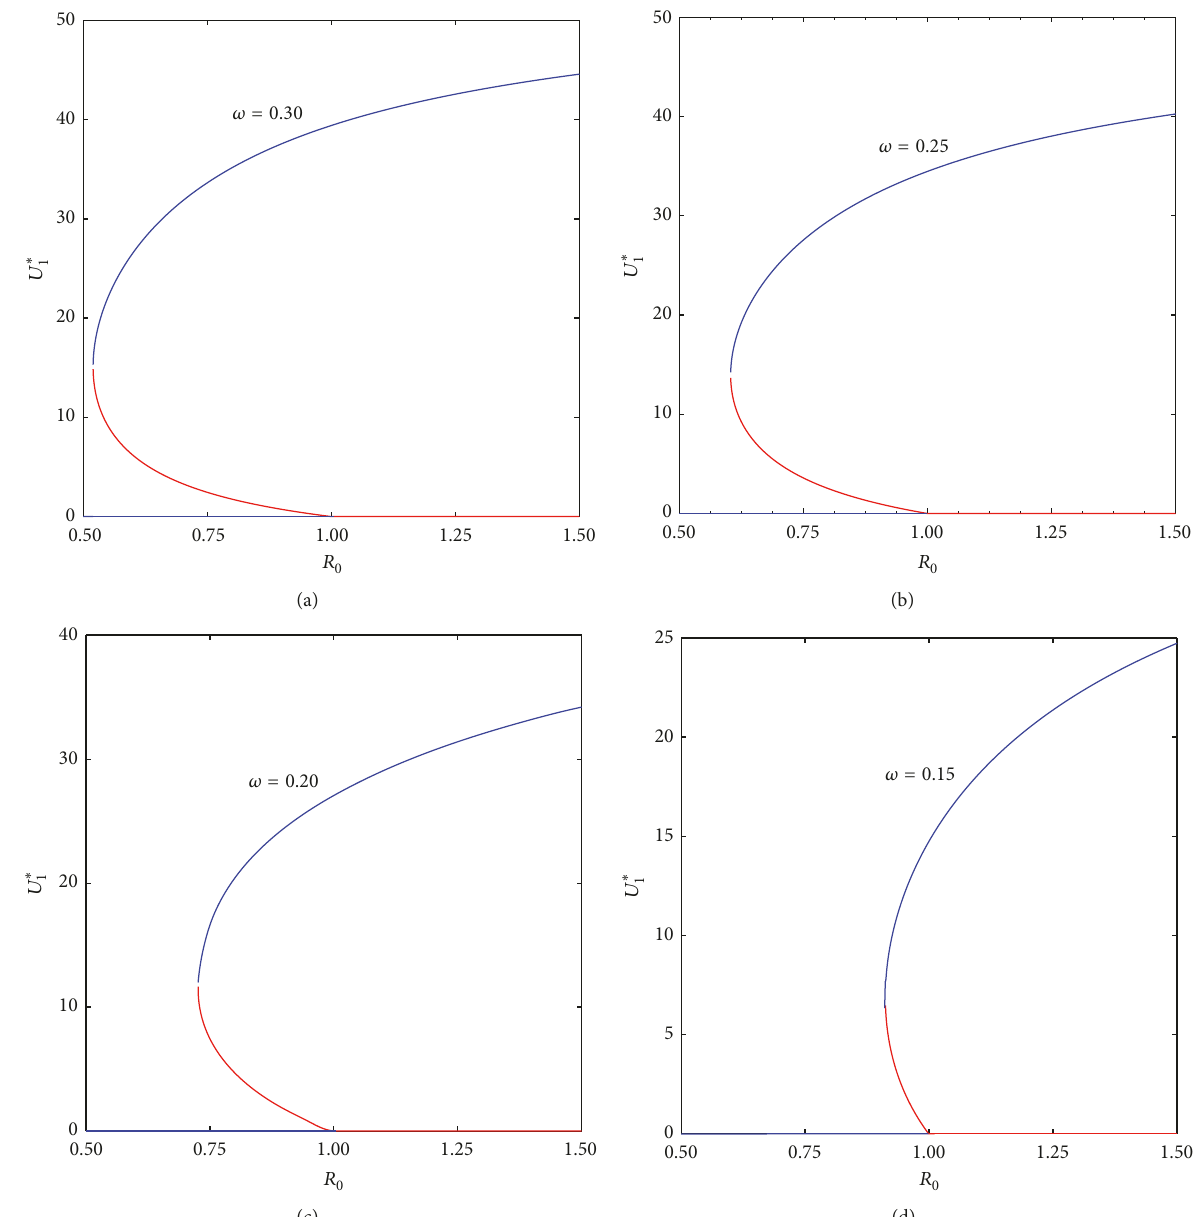
Figure 4: Illustration of the effect of increasing parameter 𝜔 that accounts for the saturation of heroin users. Here the parameters remain as in caption of Figure 3 except Λ = 2 while 𝜔 is shown in the figure. The heroin eradication thresholds (i.e., 𝑅 𝐶 0 ) corresponding to (a)–(d) are now 0.5204, 0.6038, 0.7314, and 0.9131,